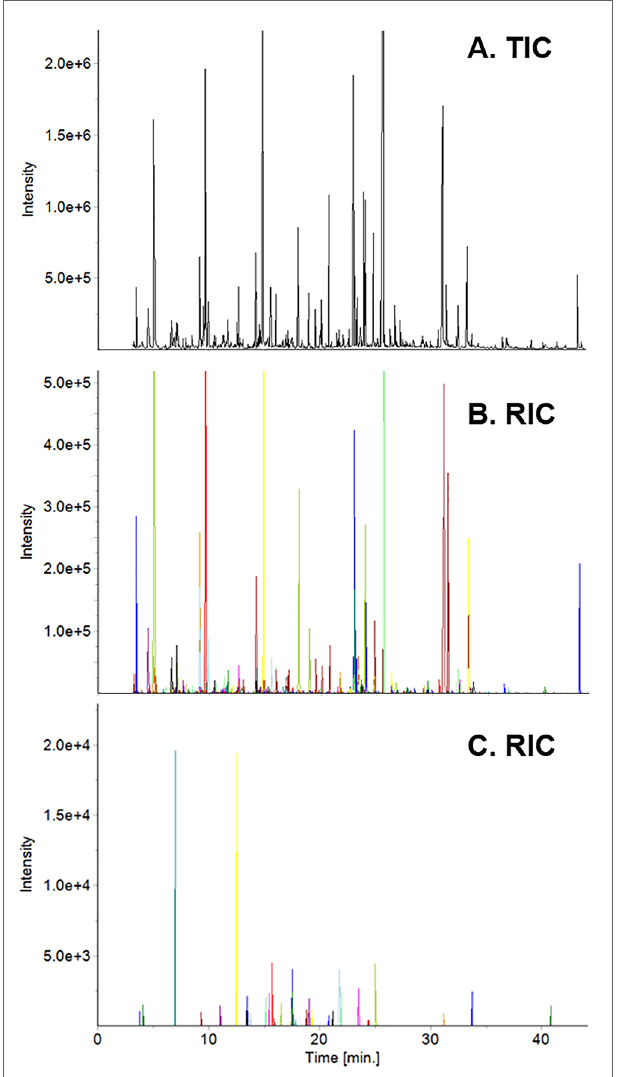
FIgURE 1 | Total ion current (TIC) chromatogram of high elevation spring tea from Fujian (a) and reconstructed ion current (RIC) chromatograms of target (B) and non-target (C) compounds. Each colored peak in the RIC corresponds to a specific compound in the